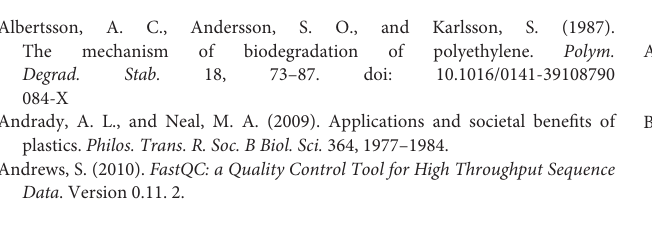
Supplementary Table 7 | RT-PCR and RNA-seq expression correlation